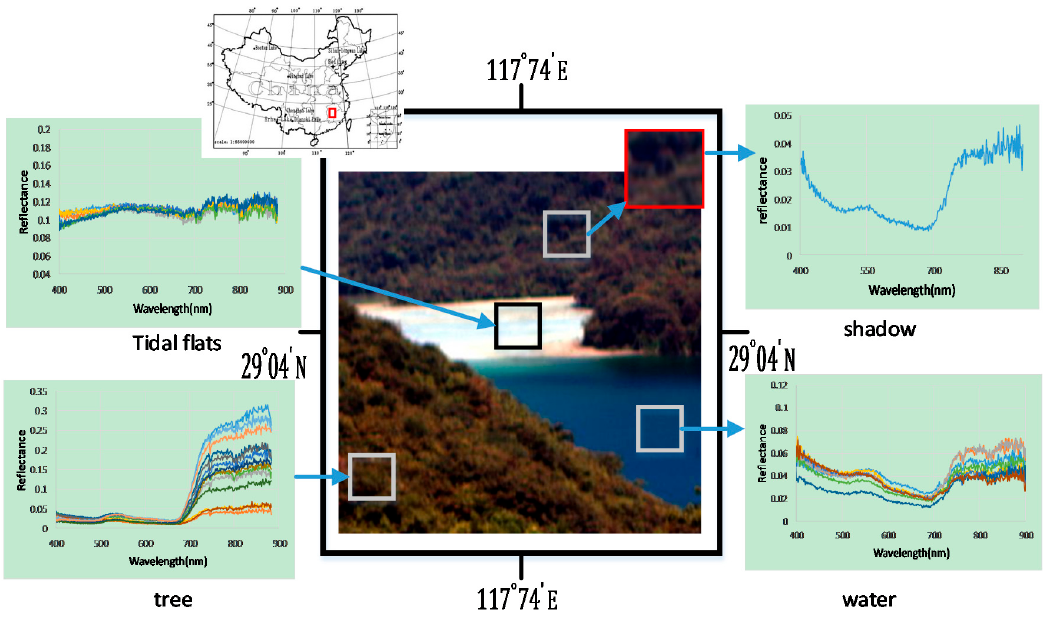
Figure 6. Illustrate the second study site near Dexing, Jiangxi Province, China. The site is dominated by tidal flats, trees, and water.